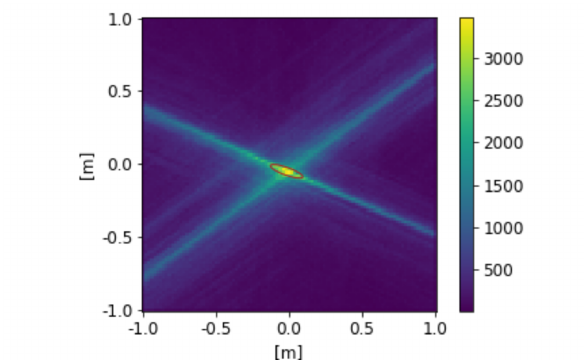
Figure 12. For the point cloud depicted in fig. 2: Accumulator and error ellipse based on the weighted sum of all consensus sets reaching at least 80 percent of the highest consensus score.